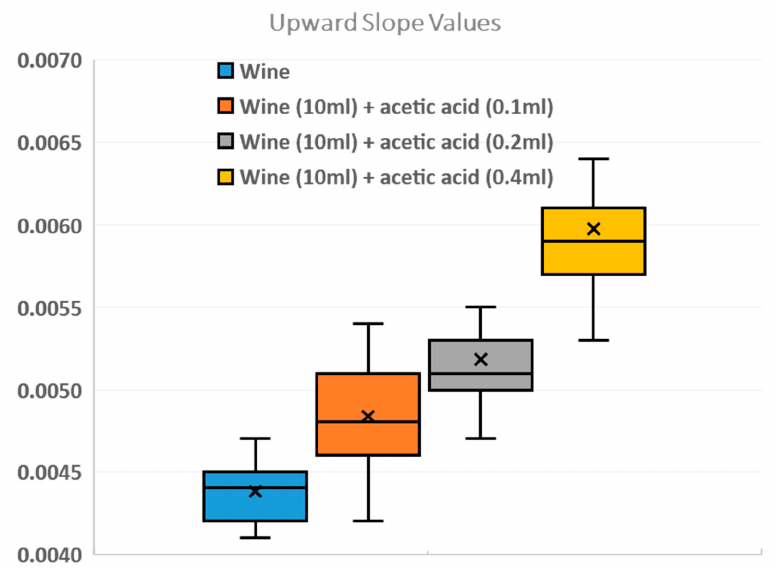
Figure 7. Box-and-whisker plot. Slope values for each test with mean and standard error, minimum, first quartile, median, third quartile, and maximum.